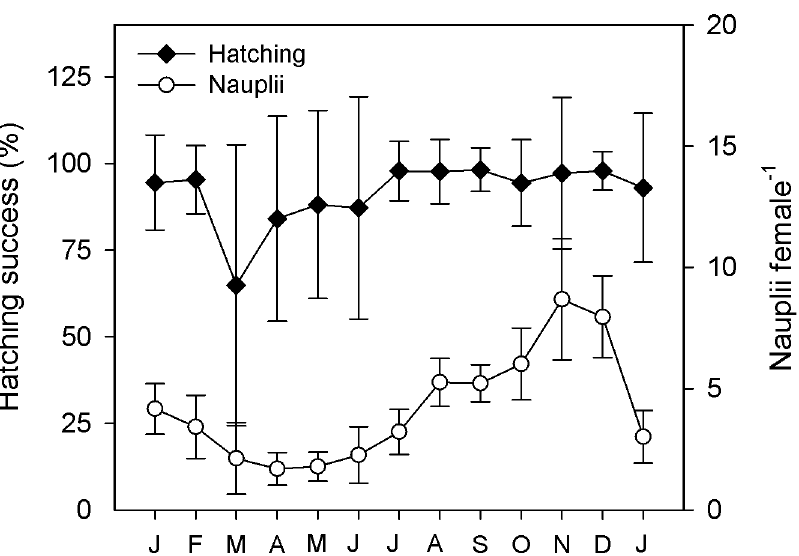
Fig 4. Temporal course of life-history traits of L . garciai in Lake Alchichica. Average proportion of eggs that hatched from a given egg sac and the average number of nauplii produced for each female. Vertical bar show ± one standard